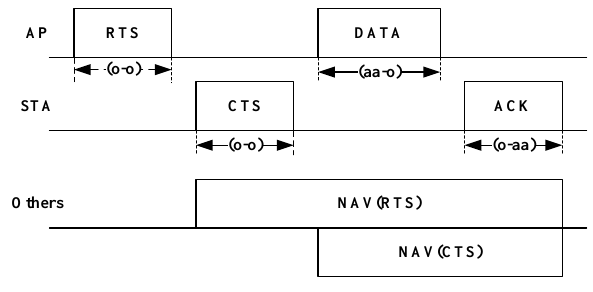
Fig. 1 Array antenna based beamforming